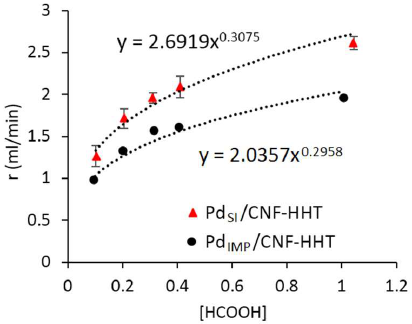
Figure 9. Effect of concentration of formic acid. Reaction conditions: 26.5 mg of catalyst (Substrate/metal molar ratio: 2000:1), 30 °C, 750 rpm, and 2 h reaction time.